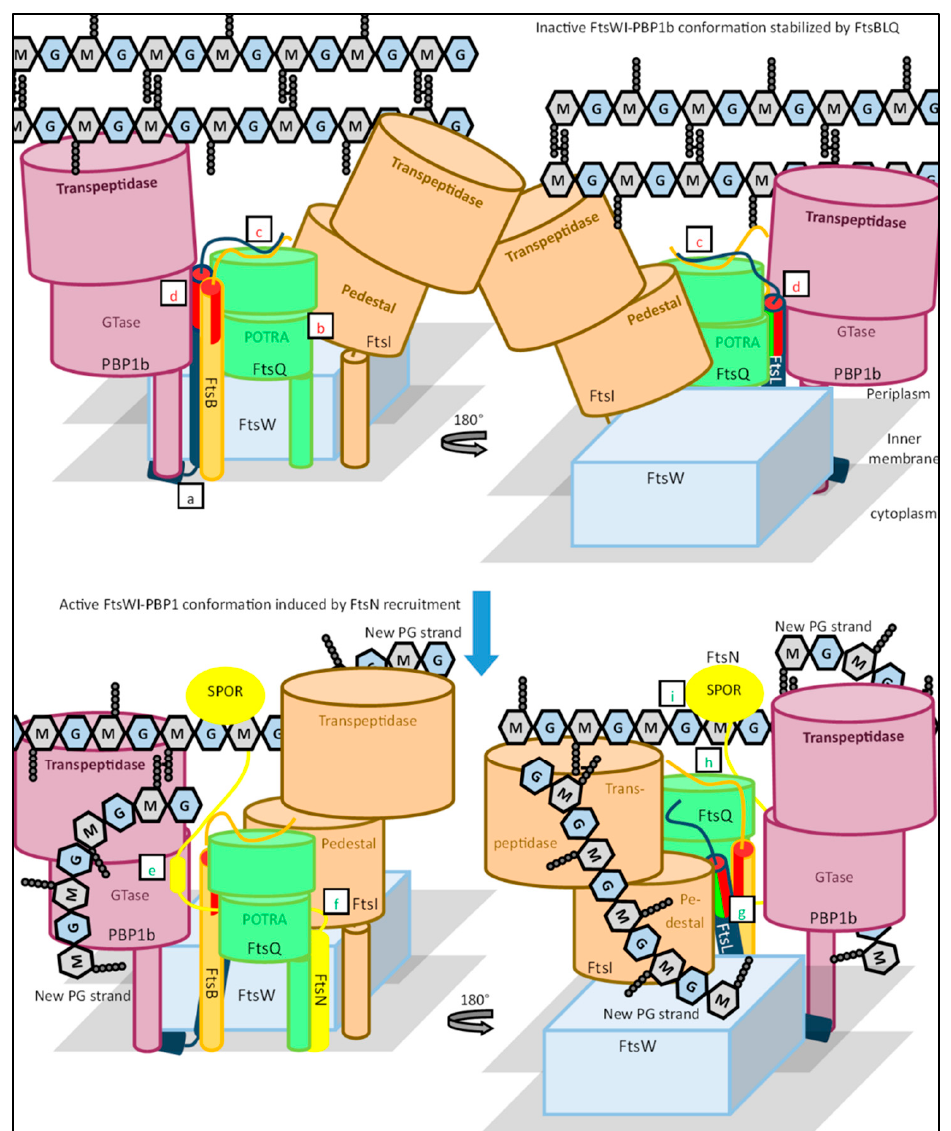
Figure 16. Regulation of FtsWI–PBP1b by FtsBLQ and FtsN. A model is proposed where FtsBLQ and FtsN stabilize the FtsWI–PBP1b septal peptidoglycan synthesis machinery in active or inactive conformations based on certain allosteric interactions. These interactions are numbered and either suppress (red), increase (green), or are neutral (black) regarding sPG synthesis. ( a ) FtsW/L cytoplas- mic interaction. This interaction between FtsL and FtsW in the cytoplasm recruits the synthesis ma- chinery to the division site. While primarily involved in recruitment, the interaction may also be involved in the stabilization of FtsW in a more active conformation. ( b ) FtsQ–FtsWI. The membrane proximal part of the FtsQ POTRA domain seems to interact with a periplasmic loop of FtsW (be- tween TM1 and TM2) and the pedestal domain of FtsI. ( c ) C-terminal FtsBLQ interaction. A strong periplasmic interaction between FtsB and FtsQ is important for the stability of the FtsBL coiled coil structure, as well as an additional C-terminal FtsB–FtsL interaction that occurs in the same region. This increased stability is thought to stabilize the whole complex in an inactive conformation, thus negatively affecting sPG synthesis. ( d ) PBP1b–FtsL. A direct interaction between PBP1b and the CCD domain of FtsL (red) suppresses PBP1b GTase activity. ( e ) PBP1b–FtsN. FtsN (yellow) also directly interacts with the same PBP1b region, outcompetes FtsL–CCD, and leads to the activation of PBP1b GTase activity. ( f ) FtsN–FtsQ. FtsN is proposed to interact with the same FtsQ region as FtsI and leads to dissociation of the inhibitory FtsQ–FtsWI interaction. ( g ) FtsL–FtsI. An interaction